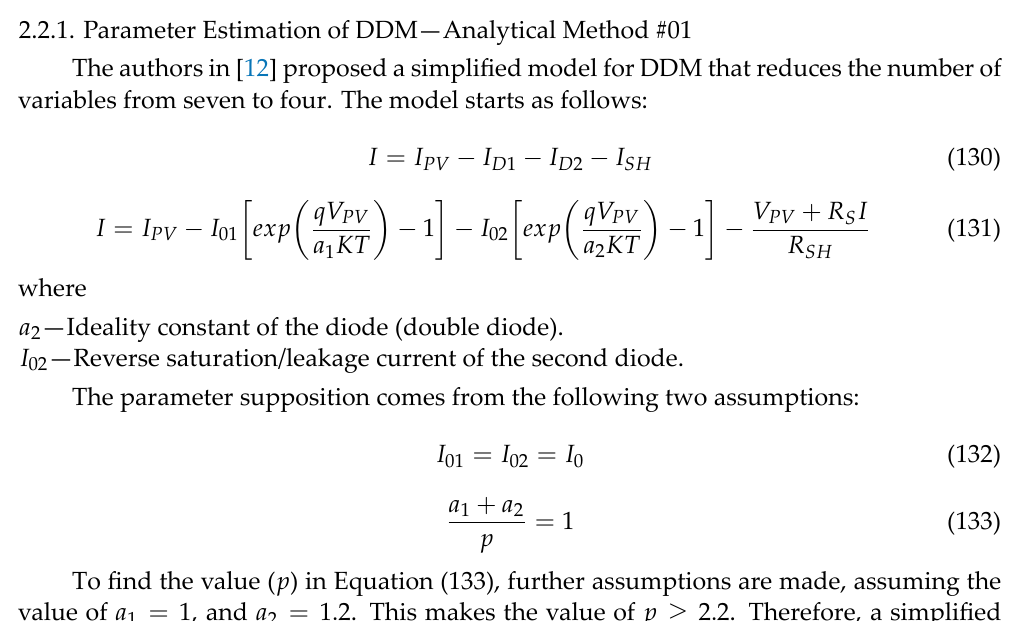
Figure 2. Circuit diagram of the double diode model.